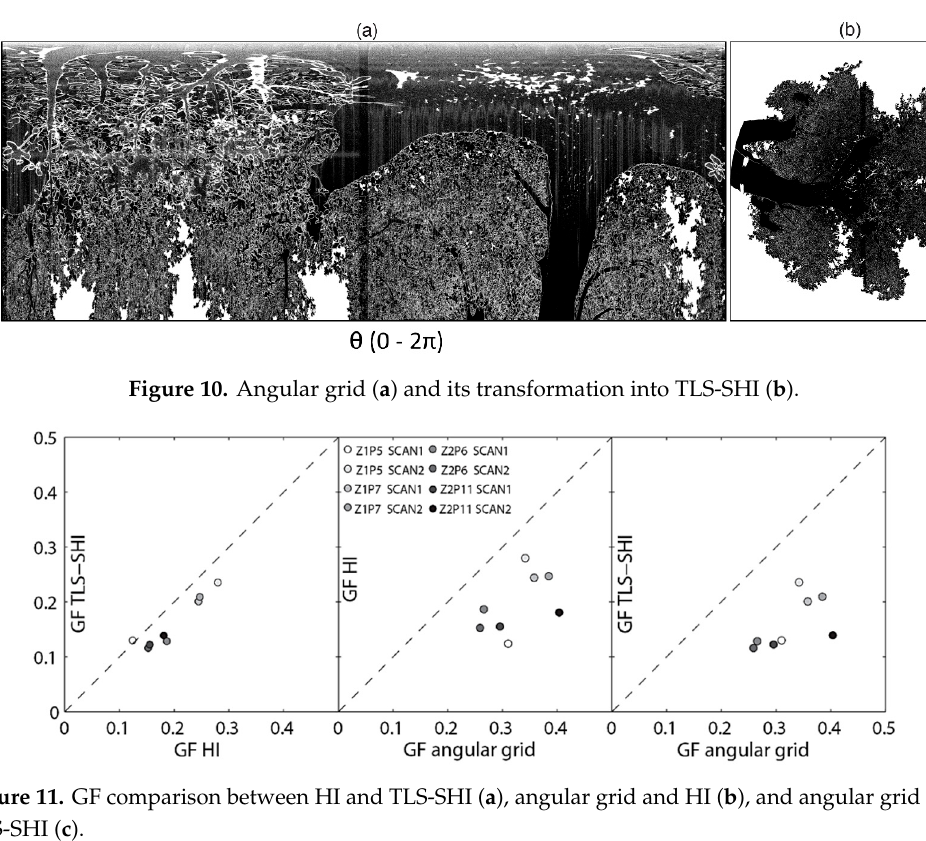
10 of 17 Table 3. Tree ID, angular resolution, noise and GF for TLS tree data. Tree ID